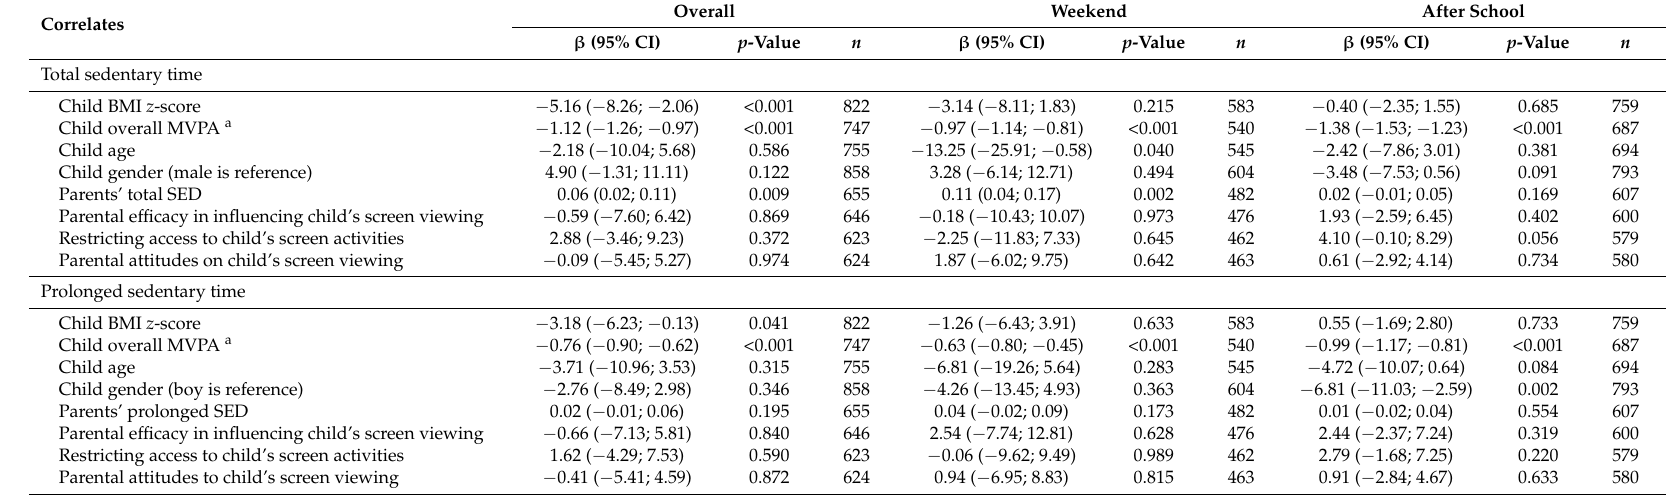
Table 3. Associations of child- and parent-related correlates with children’s total and prolonged sedentary time.